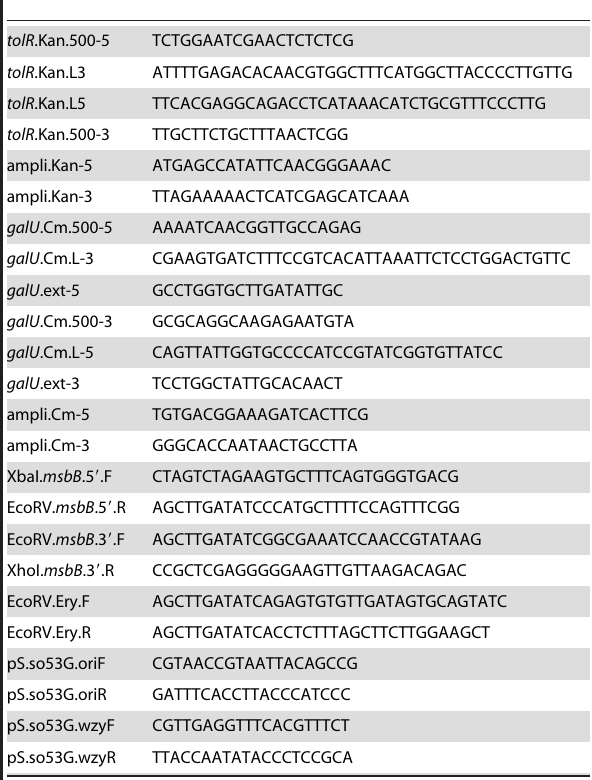
Table 1. Primers used in this